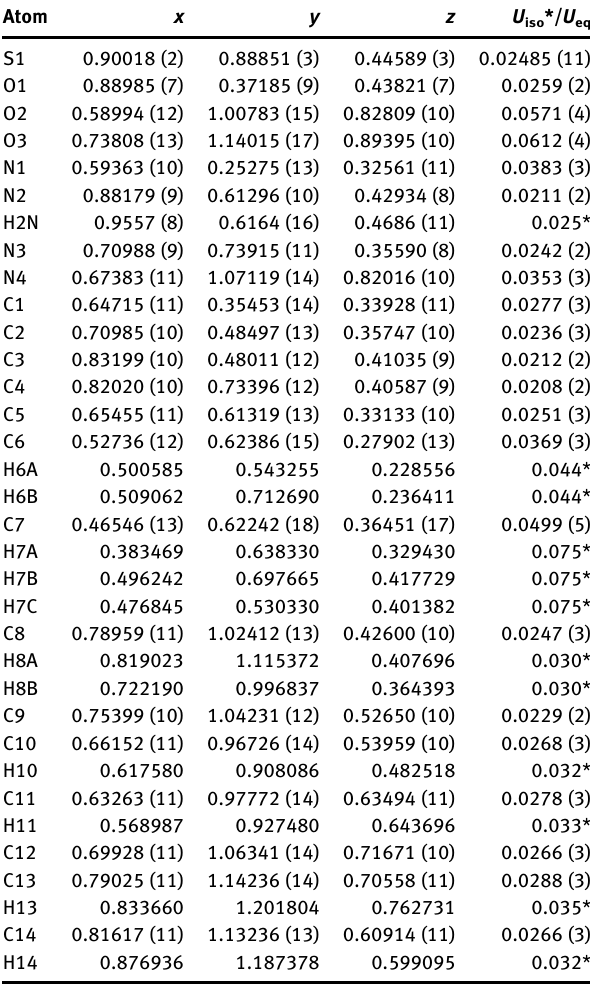
Table  : Fractional atomic coordinates and isotropic or equivalent isotropic displacement parameters (Å 